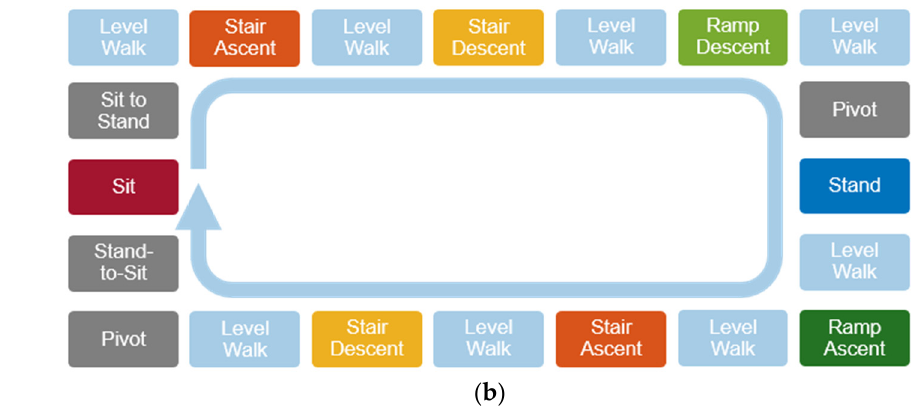
Figure 2. Experiment set up: ( a ) Ambulation circuit set up. ( b ) Ambulation mode sequence.